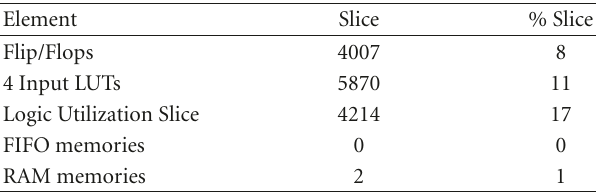
Table 2: Required FPGA resources